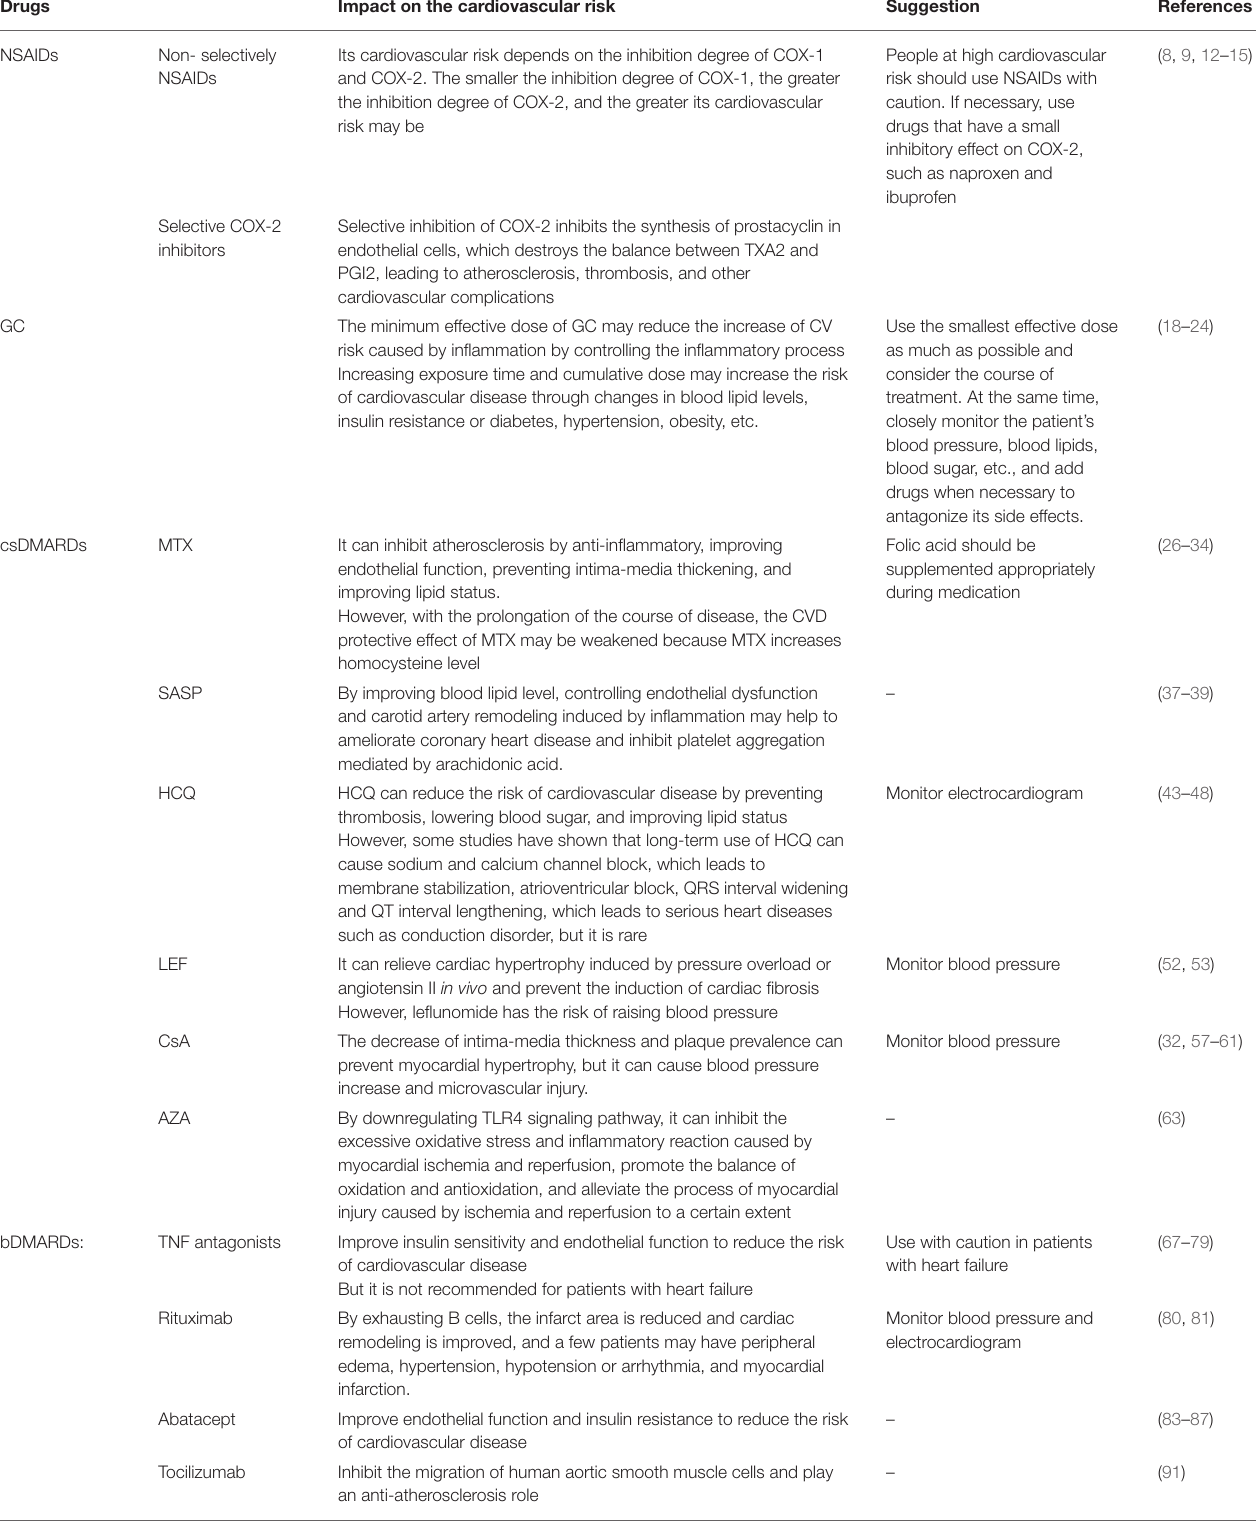
TABLE 1 | Cardiovascular risks and preventive measures of common antirheumatic drugs.